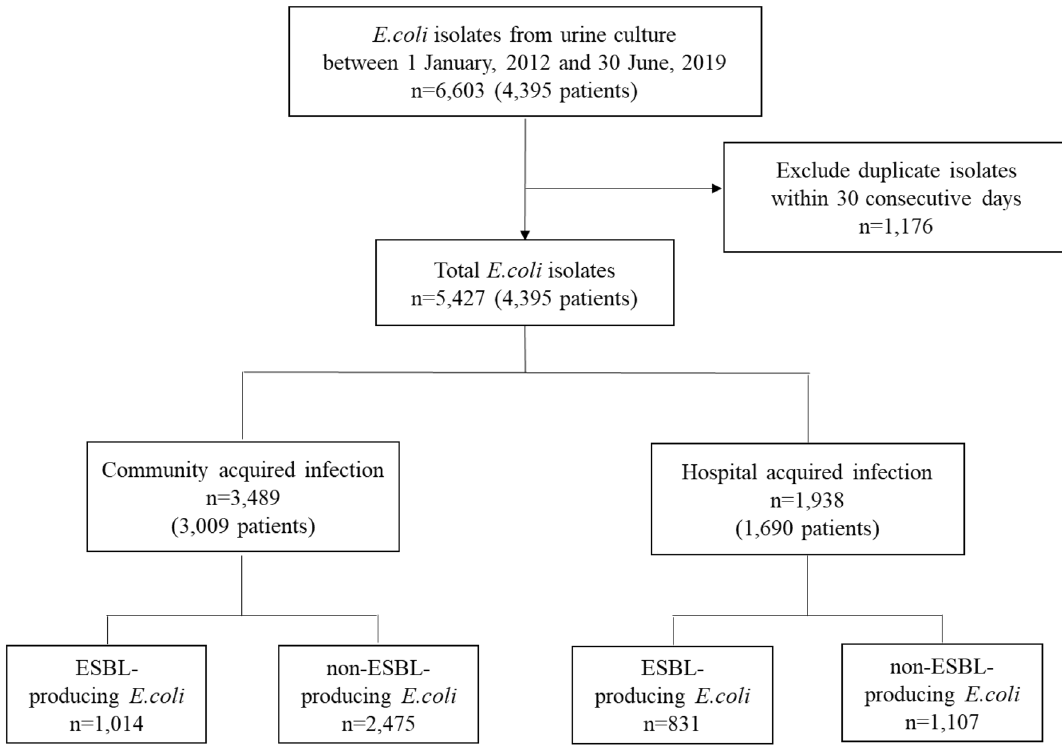
Figure 1. Flow diagram depicting the study